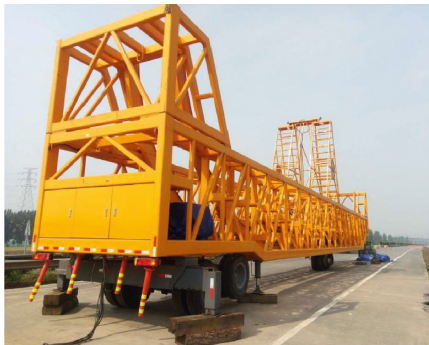
Figure 10: Full-scale APT facility.